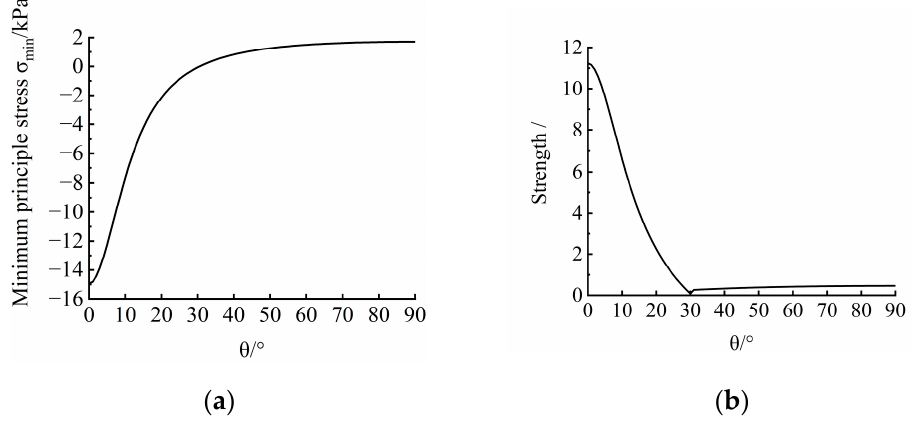
Figure 12. Phase IV ( β ≈ 10°). ( a ) Distribution of minimum principal stress; ( b ) distribution of strength.